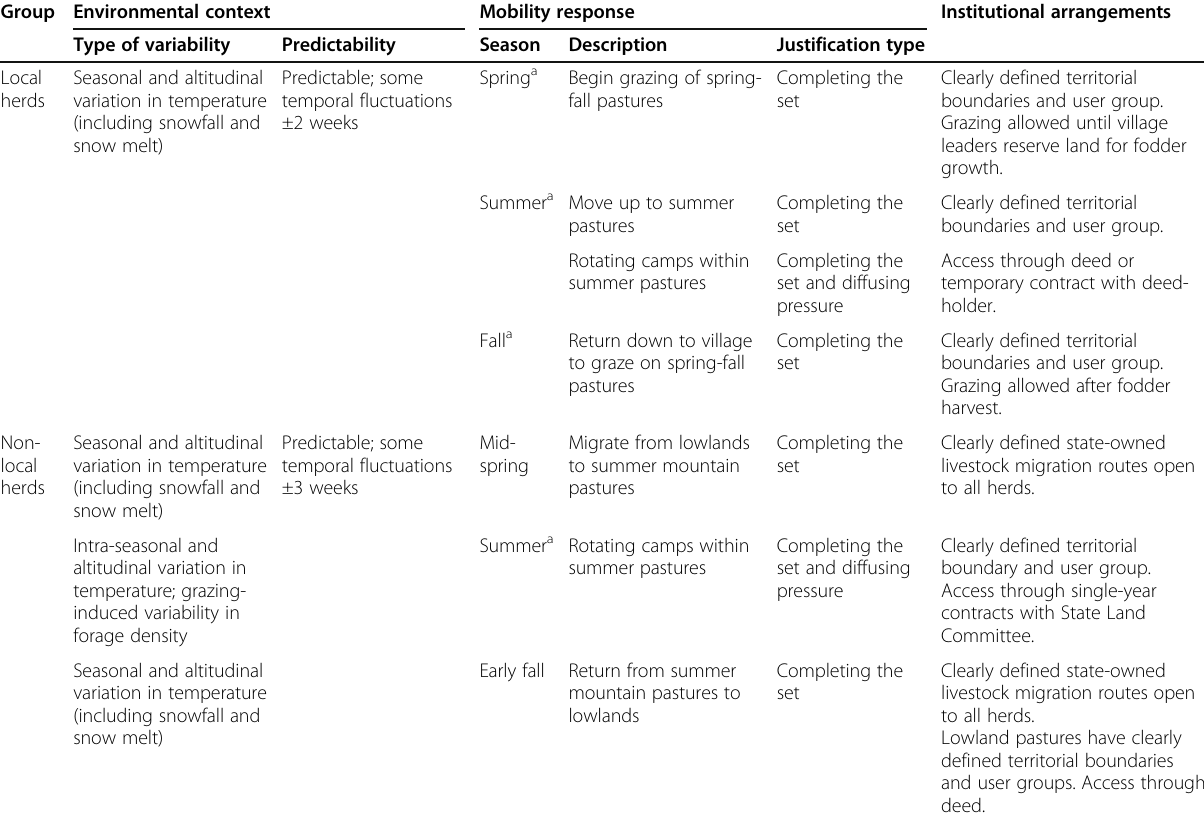
Table 3 Livestock mobility patterns in study area (April through November) Group Environmental